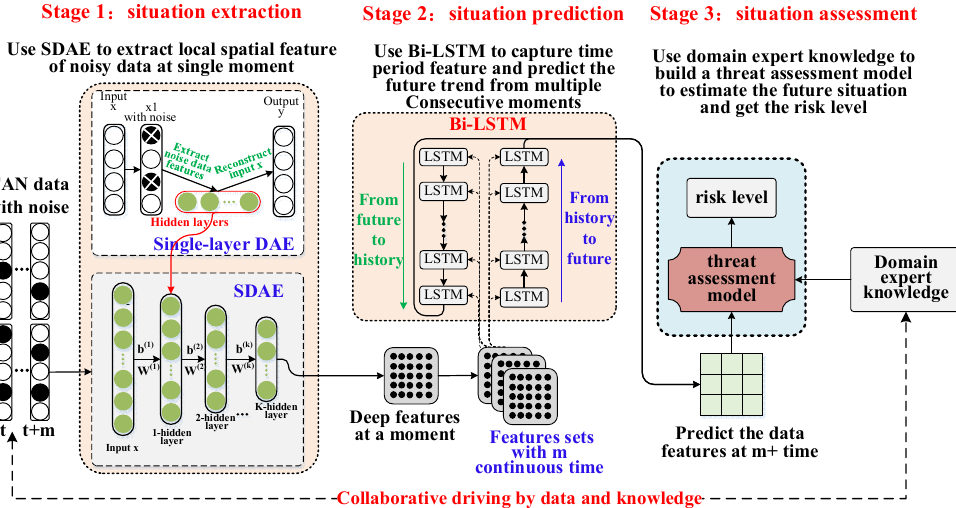
Figure 1. SDAE+Bi-LSTM-based security situation awareness model for